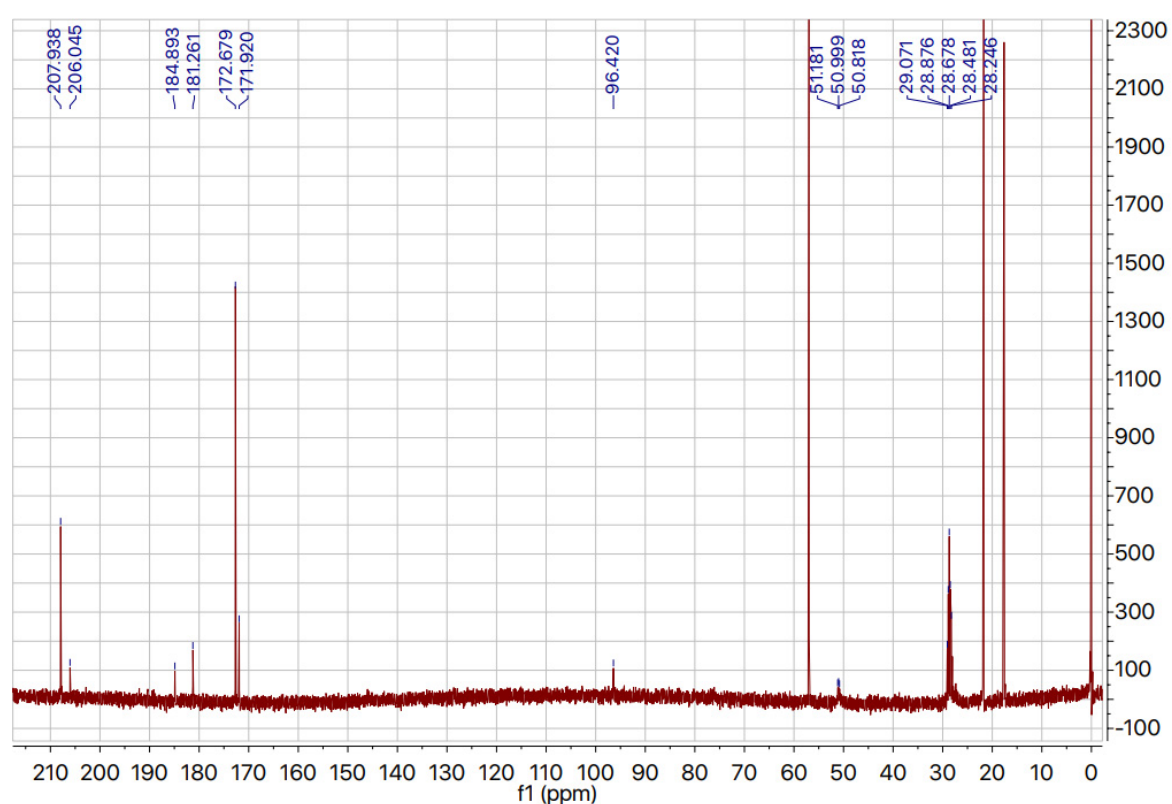
Figure 1. 13 C NMR spectrum of sodium pyruvate- d 3 in D2O with 1% ( w / w ) 3-(trimethylsilyl)-1-propanesulfonic acid, sodium salt (DSS) (reference)(x-axis: chemical shift (ppm); y-axis: intensity of signal). Peaks at 181.261 and 96.420 ppm indicate presence of pyruvate hydrate. Peaks at 181.9, 184.9, 206.0, and 50.0 ppm indicate possible presence of parapyruvate (dimer). Peaks between 29.1 and 28.2 ppm indicate C d 3 signal of sodium pyruvate- d 3 .